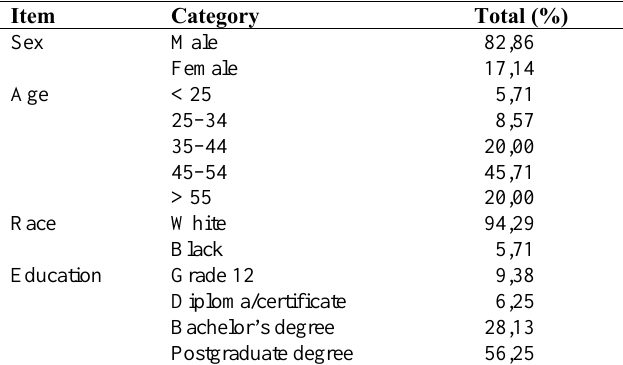
Table 2: Biographic information on the